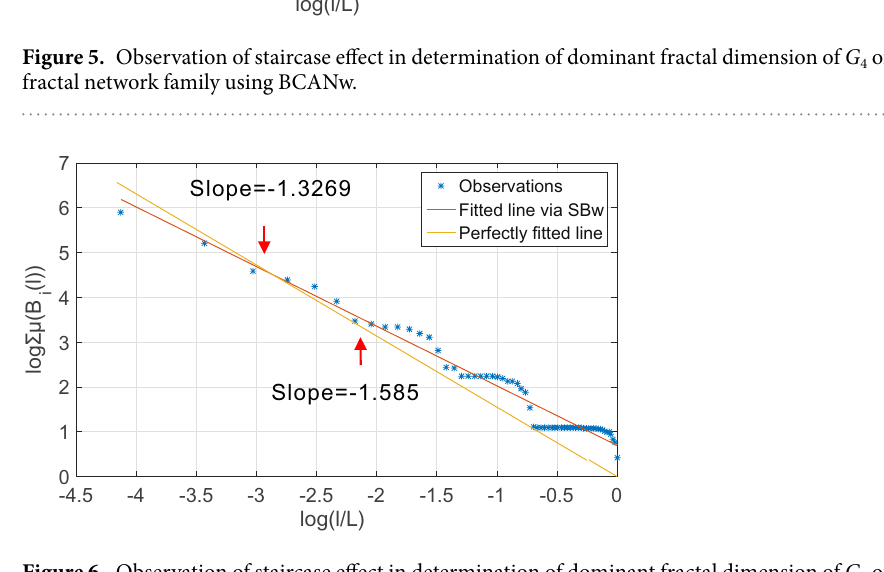
Figure 6. Observation of staircase effect in determination of dominant fractal dimension of G 4 of Sierpinski fractal network family using